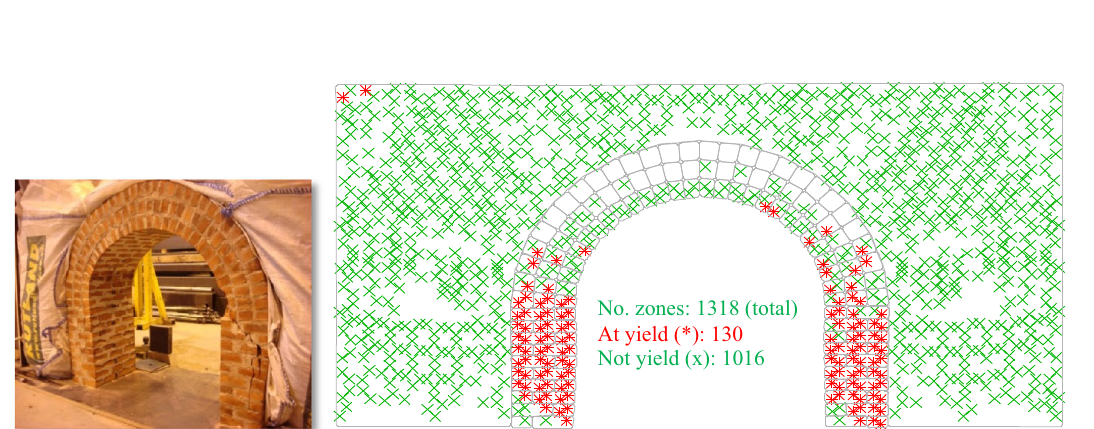
Deformation trend